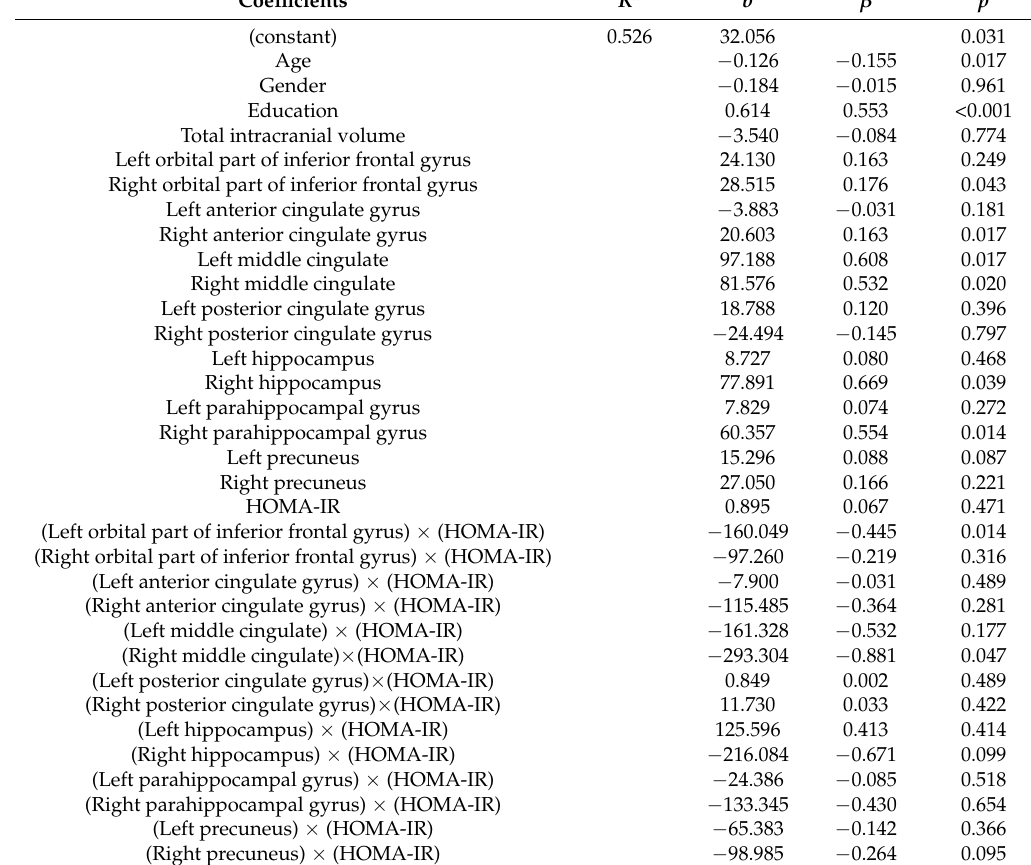
Table 3. Analysis for moderating effect of insulin resistance by the hierarchical moderated multiple regression